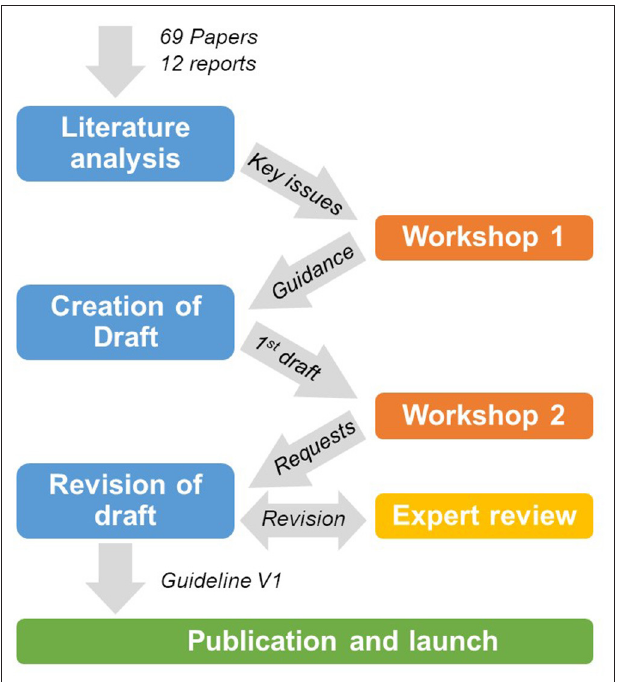
FIGURE 1 | Development approach.